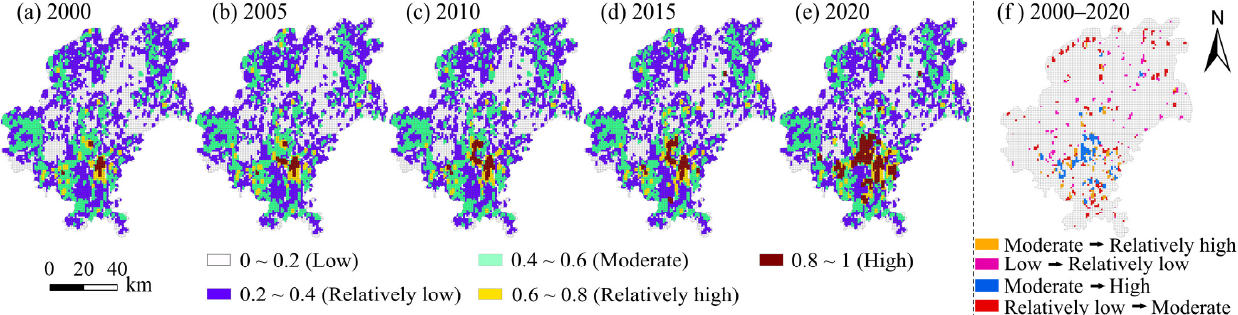
Figure 4. Spatial distribution of human activity intensity in Guiyang from 2000 to